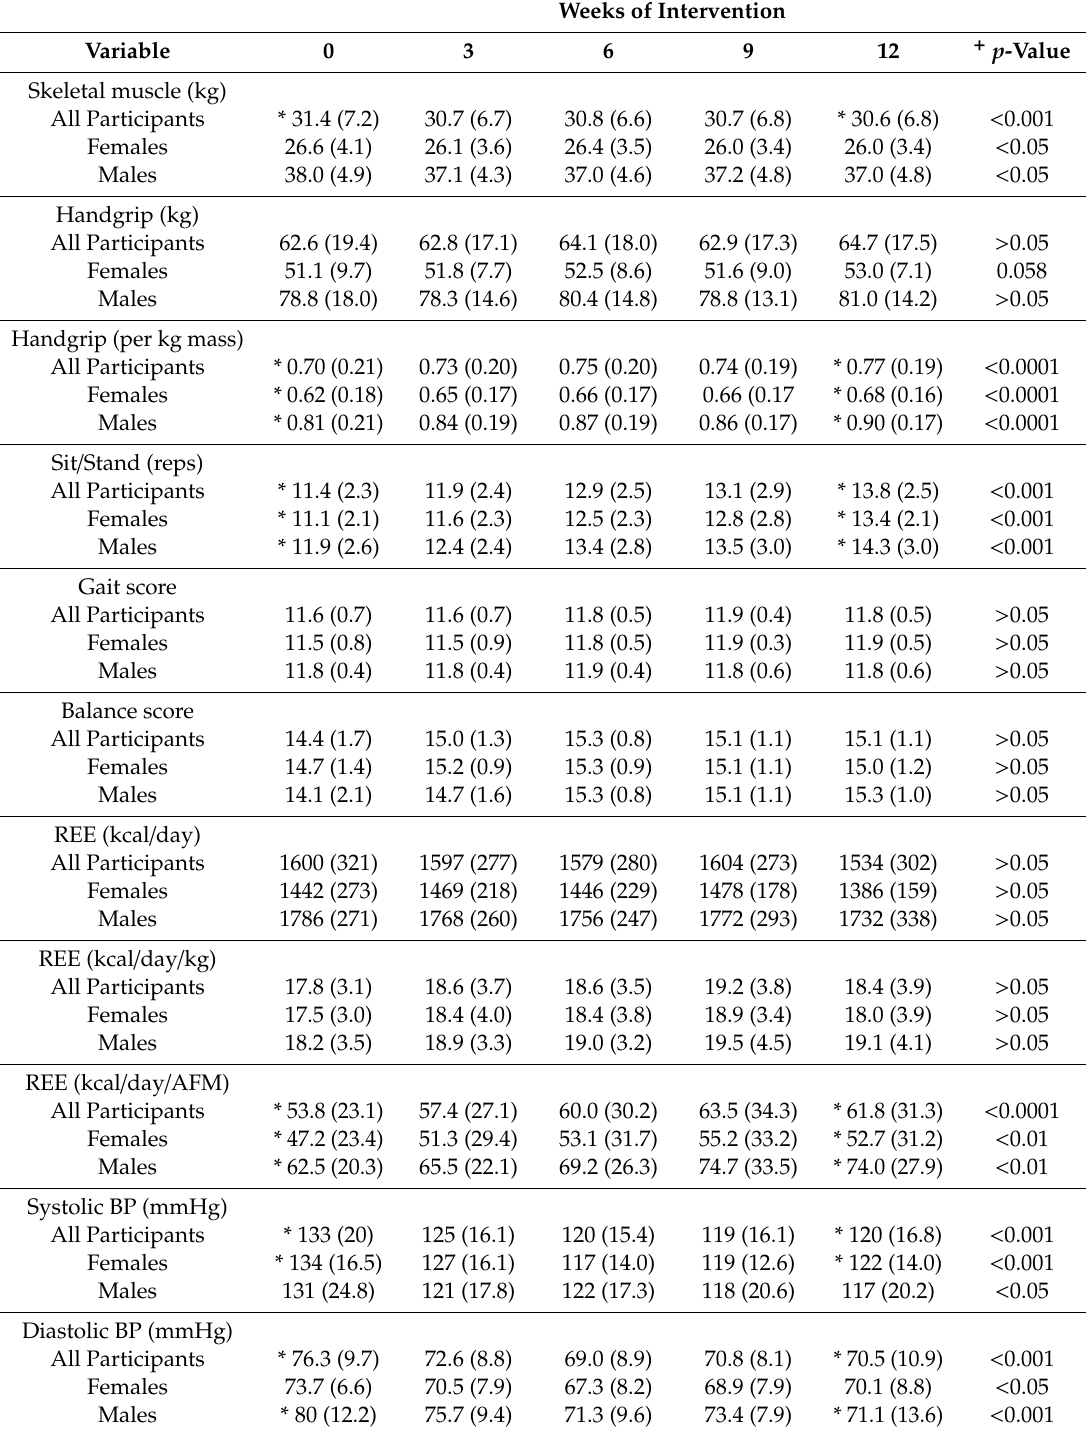
Table 4. Muscle and metabolic health in older adults consuming the DASH diet containing meat. Weeks of